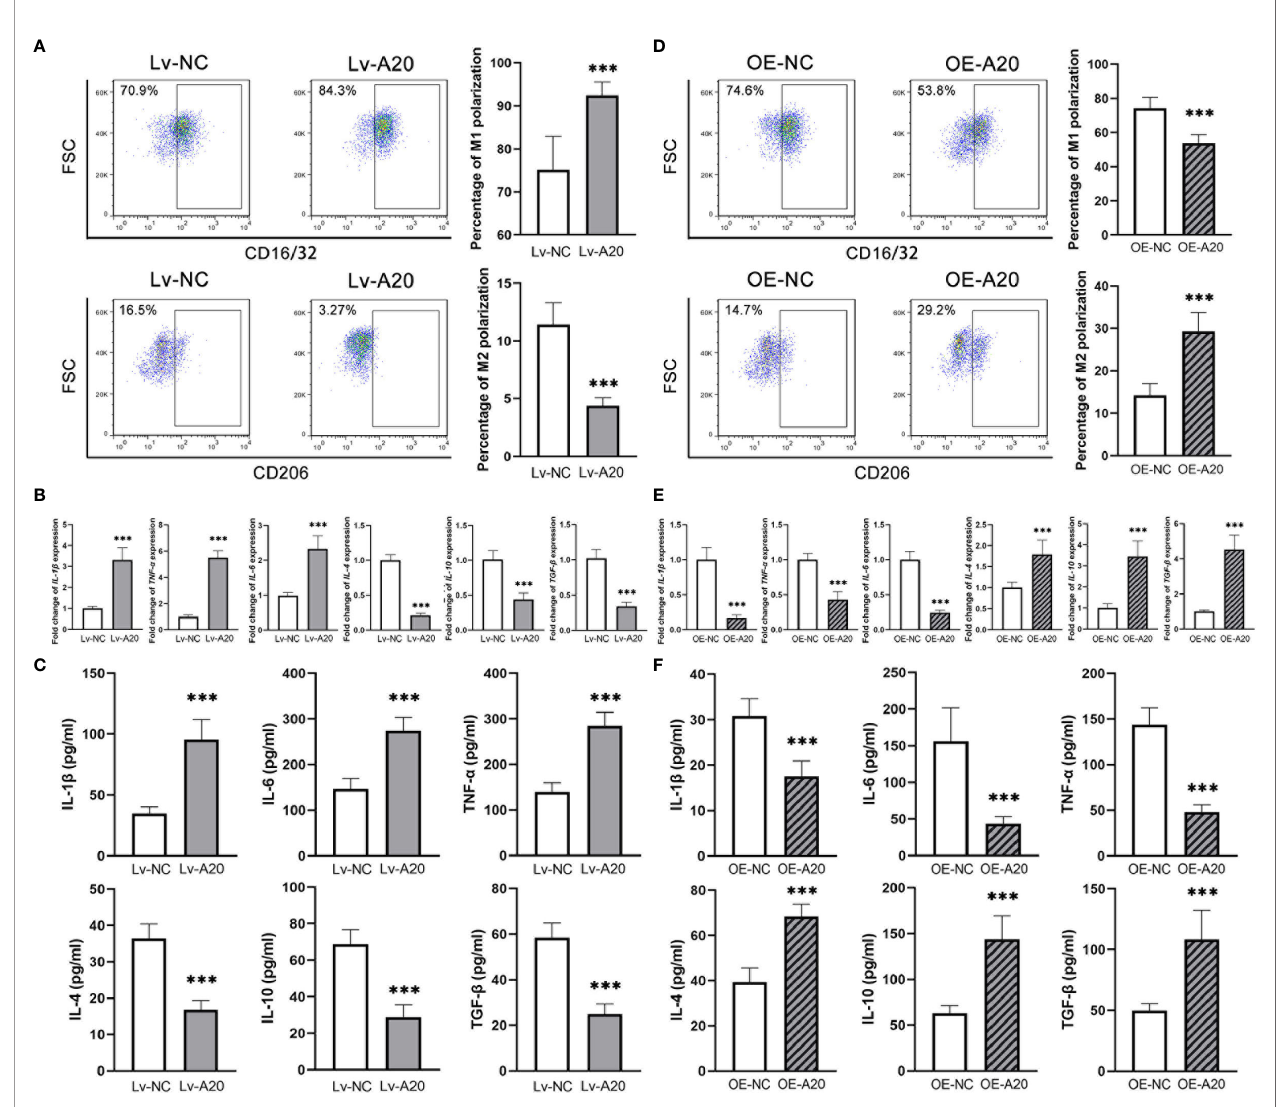
FIGURE 4 | A20 negatively regulated the M1 polarization of BV2 microglia. (A) The percentage of CD16/32 + M1 microglia was higher in the Lv-A20 group than in the Lv-NC group. The percentage of CD206 + M2 microglia was lower in the Lv-A20 group than in the Lv-NC group. (B) The IL-1 b , IL-6 and TNF- a expression at mRNA levels were higher in the Lv-A20 group than the Lv-NC group, and the IL-4, IL-10 and TGF- b expression at mRNA levels were lower in the Lv-A20 group than the Lv-NC group. (C) The IL-1 b , IL-6 and TNF- a secretion levels were higher in the Lv-A20 group than the Lv-NC group, and the IL-4, IL-10 and TGF- b secretion levels were lower in the Lv-A20 group than the Lv-NC group. (D) The percentage of CD16/32 + M1 microglia was lower in the OE-A20 group than in the OE-NC group. The percentage of CD206 + M2 microglia was higher in the OE-A20 group than in the OE-NC group. (E) The IL-1 b , IL-6 and TNF- a expression at mRNA levels were lower in the OE-A20 group than the OE-NC group, and the IL-4, IL-10 and TGF- b expression at mRNA levels were higher in the OE-A20 group than the OE-NC group. (F) The IL-1 b , IL-6 and TNF- a secretion levels were lower in the OE-A20 group than the OE-NC group, and the IL-4, IL-10 and TGF- b secretion levels were higher in the OE-A20 group than the OE-NC group. Values are presented as the mean ± SD. *** indicates P <